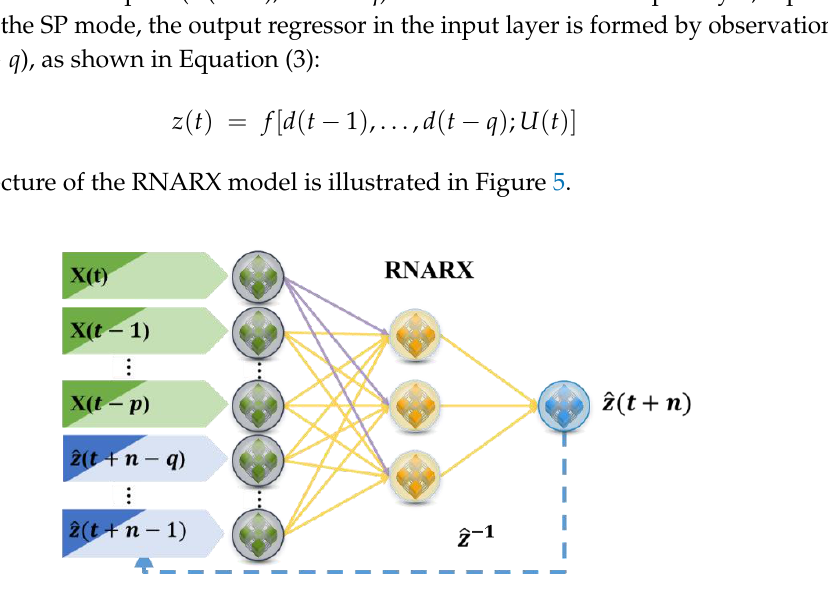
Figure 5. Architecture of the RNARX network. X and 𝑍̂ denote observed and forecasted values, respectively.